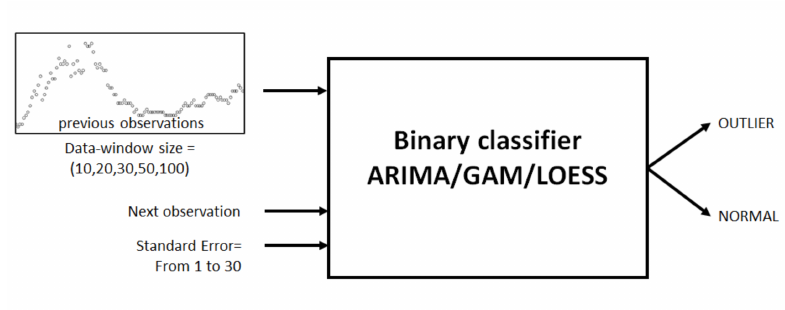
Figure 6. Black-box diagram of a binary